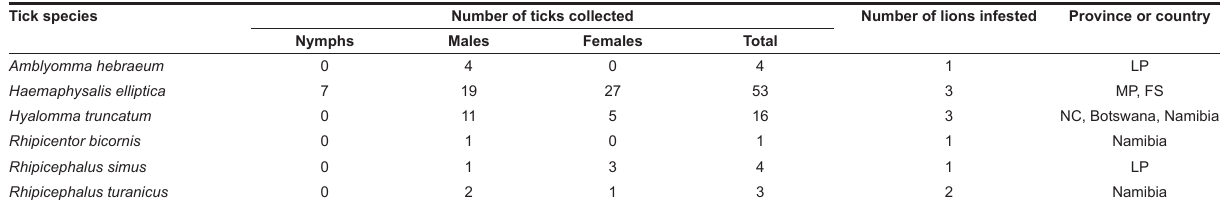
TABLE 5 Ticks collected from 9 lions in South Africa, Botswana and Namibia